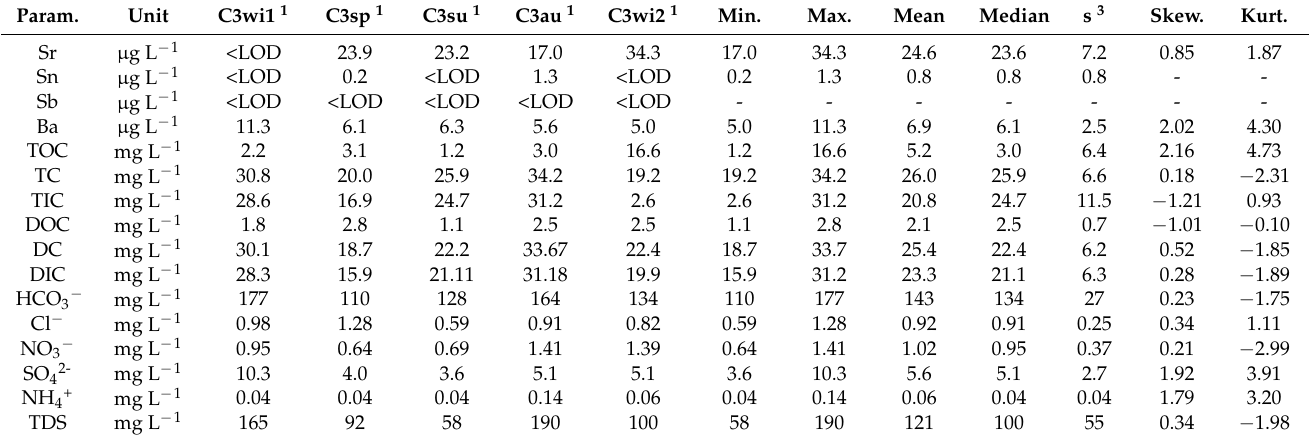
ani Cave. C2—water , ani Cave are shown in ,